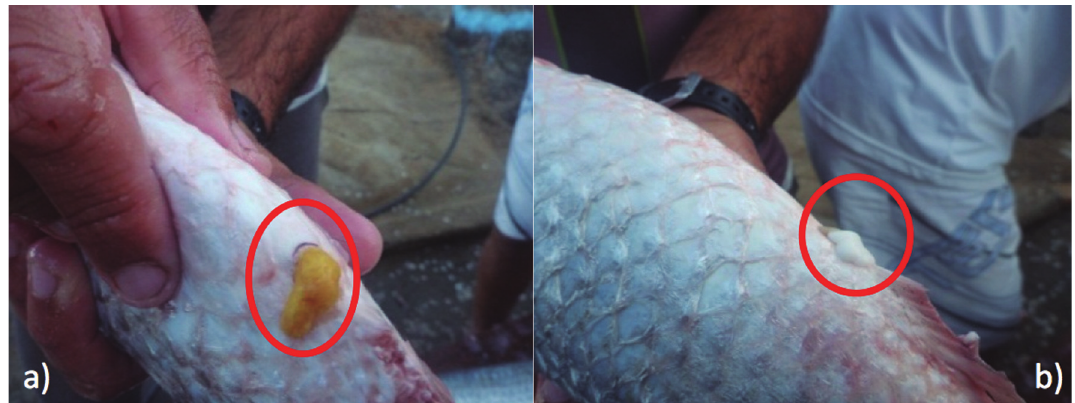
Fig. 4. Abdominal checking of mullet ( Mugil liza ) sex. a) Female: yellow eggs (n=27) through the urogenital orifice, and b) Male: white eggs/sperm (n=36) through the urogenital